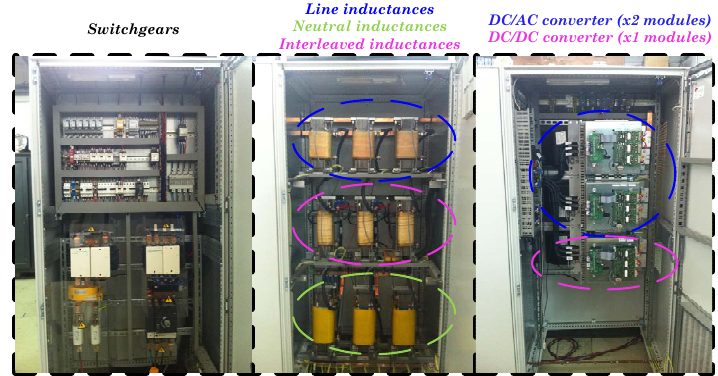
Figure 8. Converter installed in the ATENEA experimental microgrid.